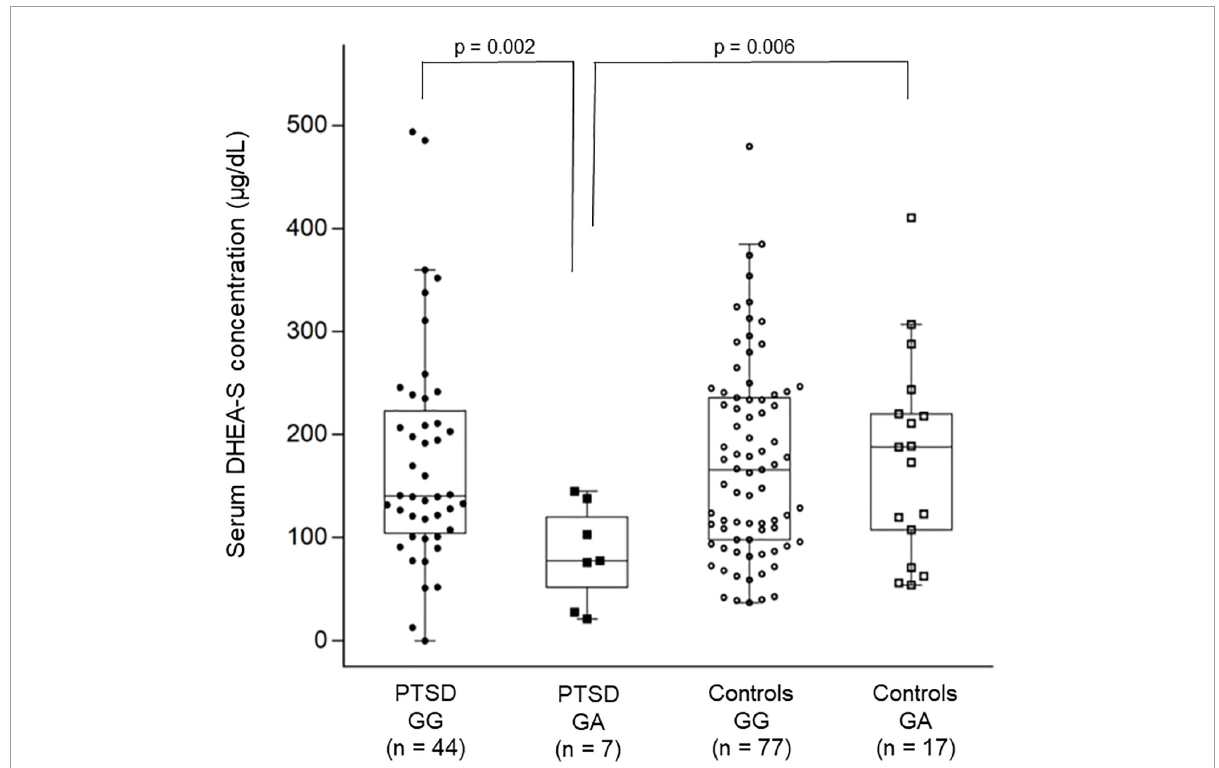
FIGURE2 Combined dot- and box-plot showing the comparison of serum DHEA-S levels as a function of diagnostic groups and the CACNA1C rs1006737 genotype groups. Comparison of log-transformed DHEA-S levels was made by the two-way ANOVA. In this figure, raw data of DHEA-S levels without log-transformation is